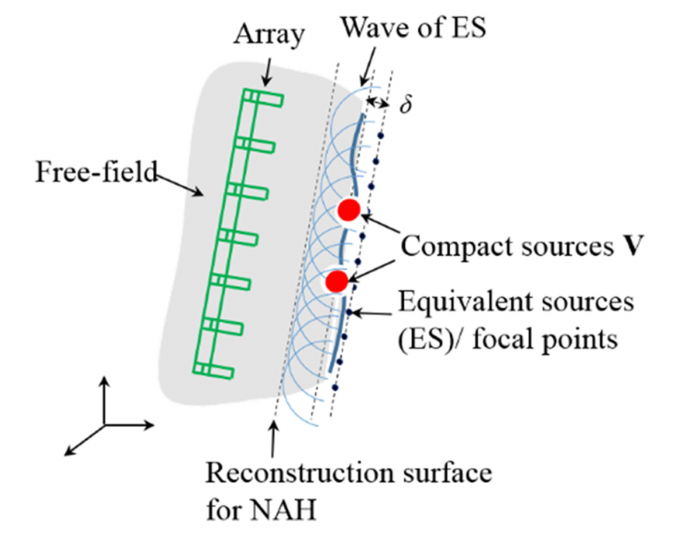
Figure 1. The diagrammatic sketch of the source-receiver model for acoustic